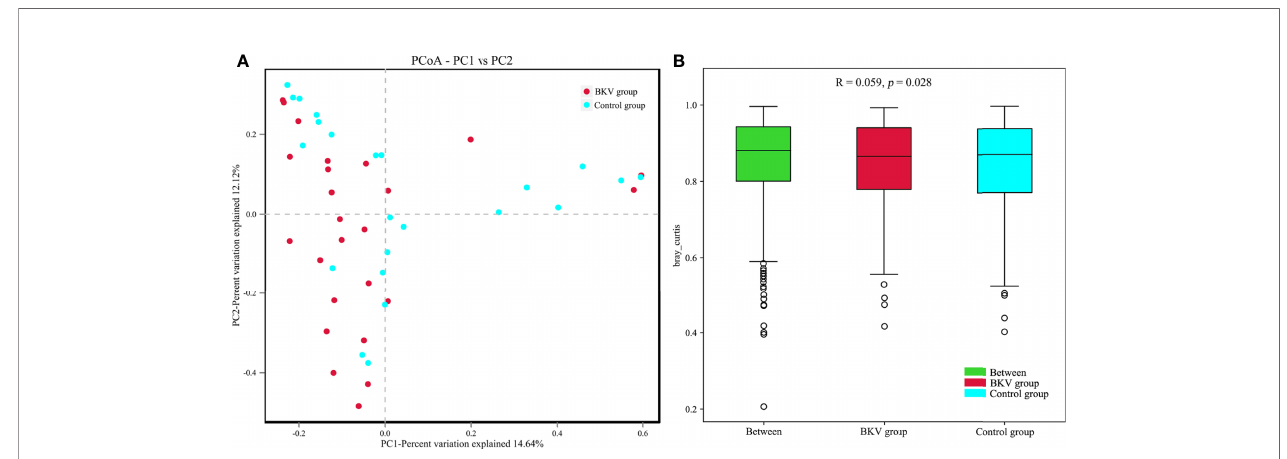
FIGURE 3 | Comparative analysis between the BKV group and the control group. (A) PCoA was performed based on the Bray – Curtis distance. Clustering patterns of the BKV and control groups were identi fi ed by red and blue colors, respectively. PC1 and PC2 explained 14.64% and 12.12% of total variations, respectively. (B) ANOSIM at the OTU level was conducted. The difference in microbiota in the inter-group was bigger than that in the